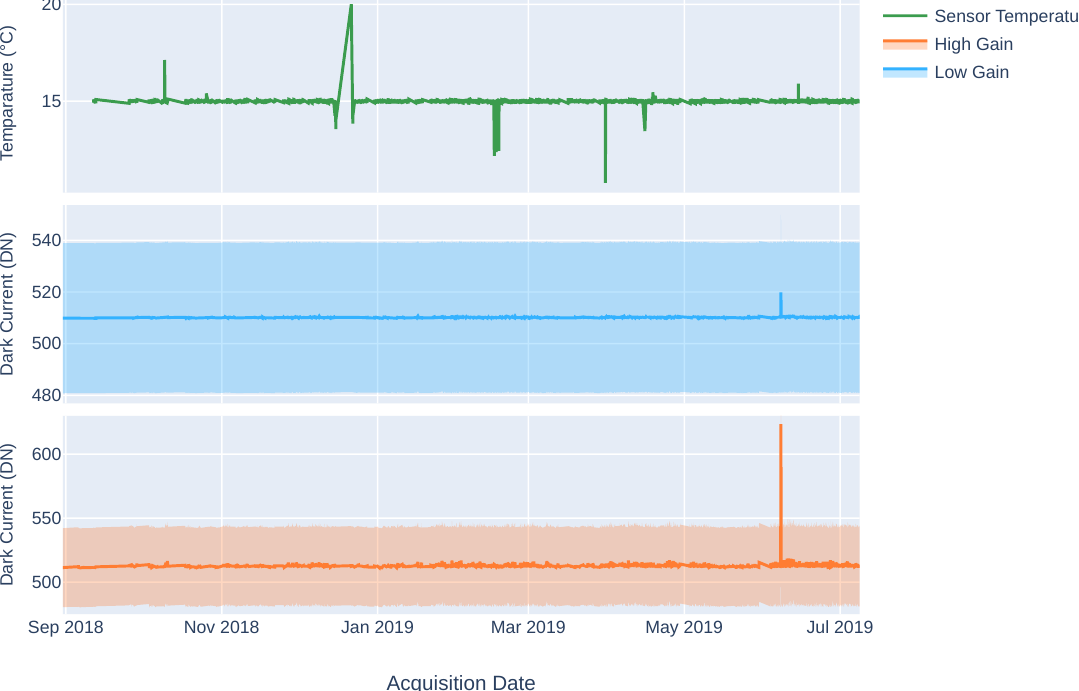
Figure 6. DESIS sensor historical monitoring results: ( Top ) historical temperatures of the focal plane; and ( middle , bottom ) historical DC values averaged for the whole focal plane and for a gain factor × 2 and × 10,